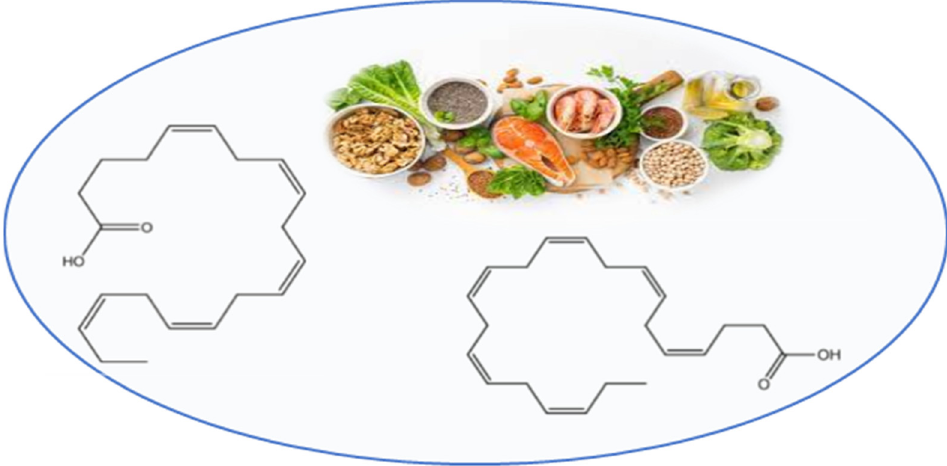
Figure 4. Chemical structures of eicosapentaenoic acid ( left ) and docosahexaenoic acid ( right